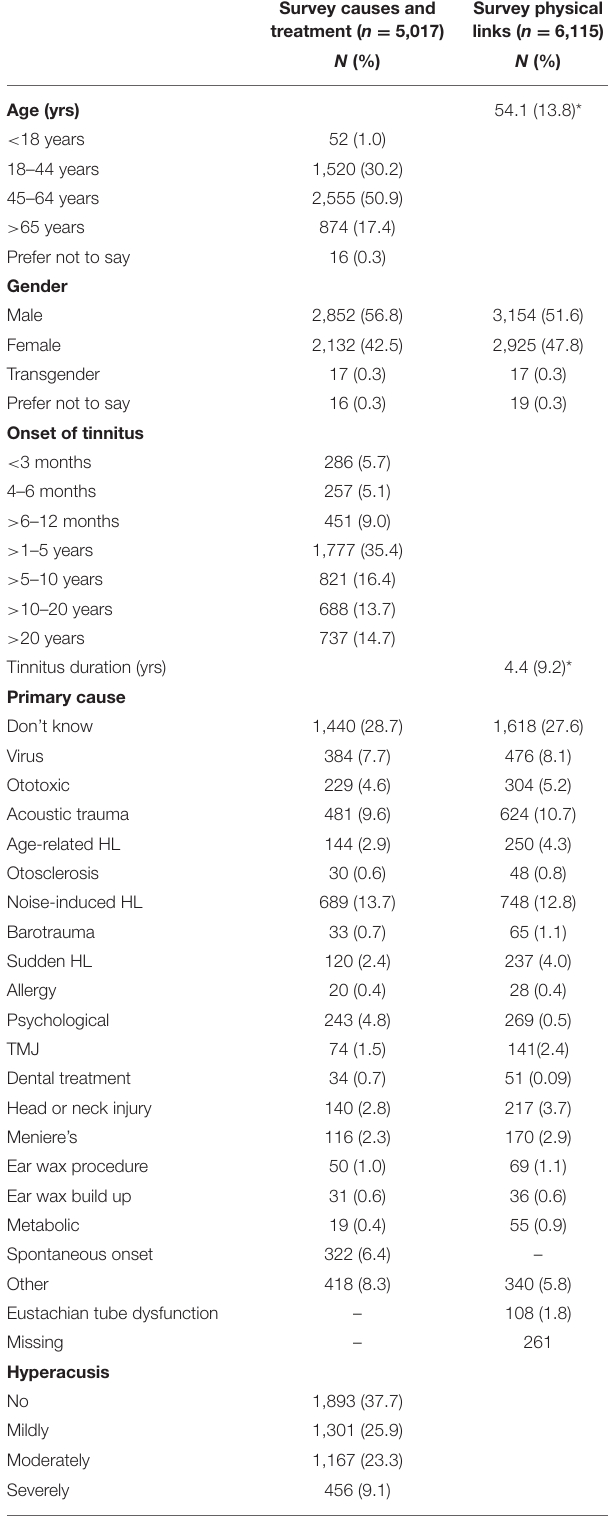
TABLE 1 | Baseline characteristics of participants to surveys in numbers of participants (and %).